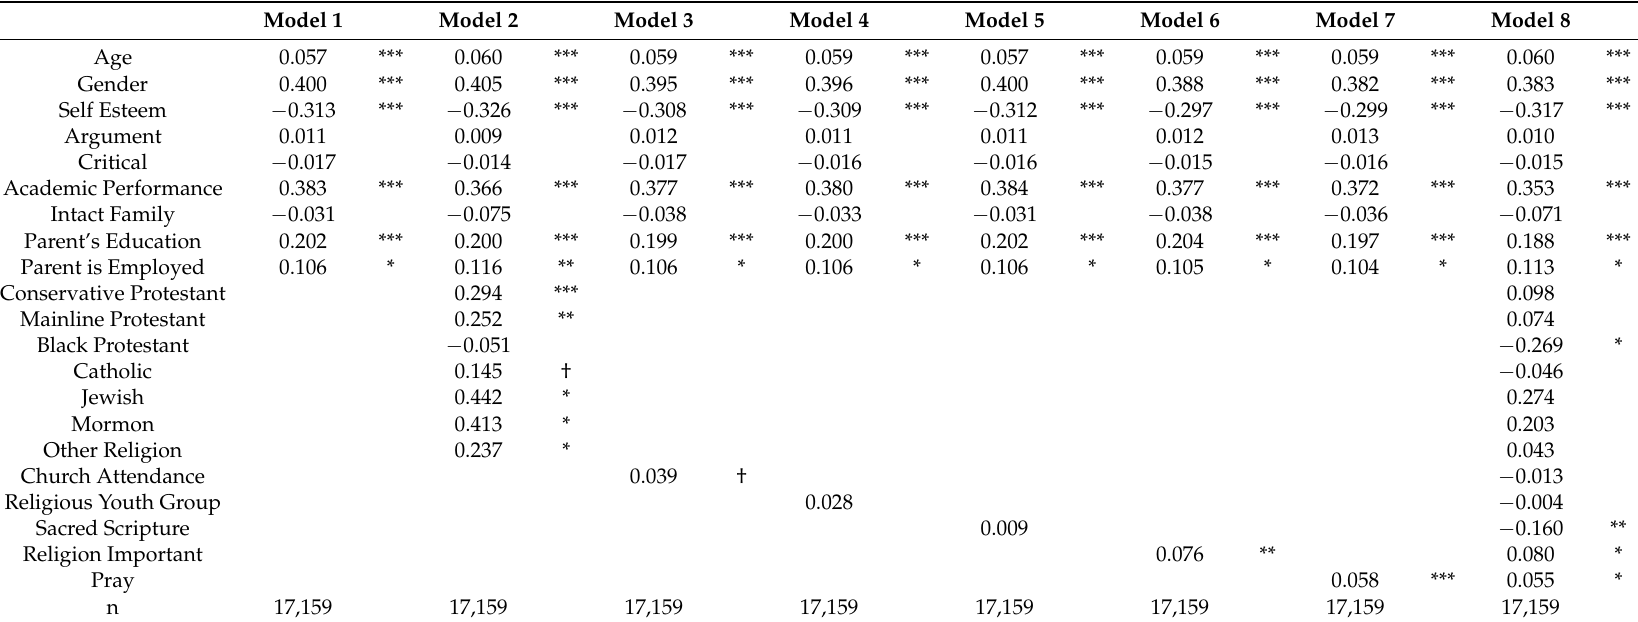
Table 2. Ordered Logistic Regression to Predict Interpersonal Warmth.